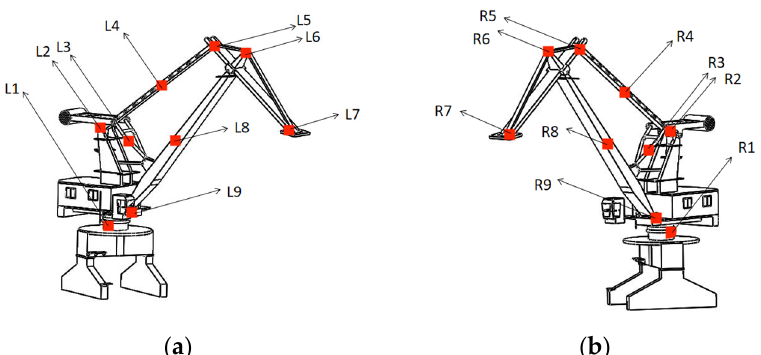
Figure 1. Mark of vulnerable parts of a gantry crane: ( a ) vulnerable parts on the left; ( b ) vulnerable parts on the right.